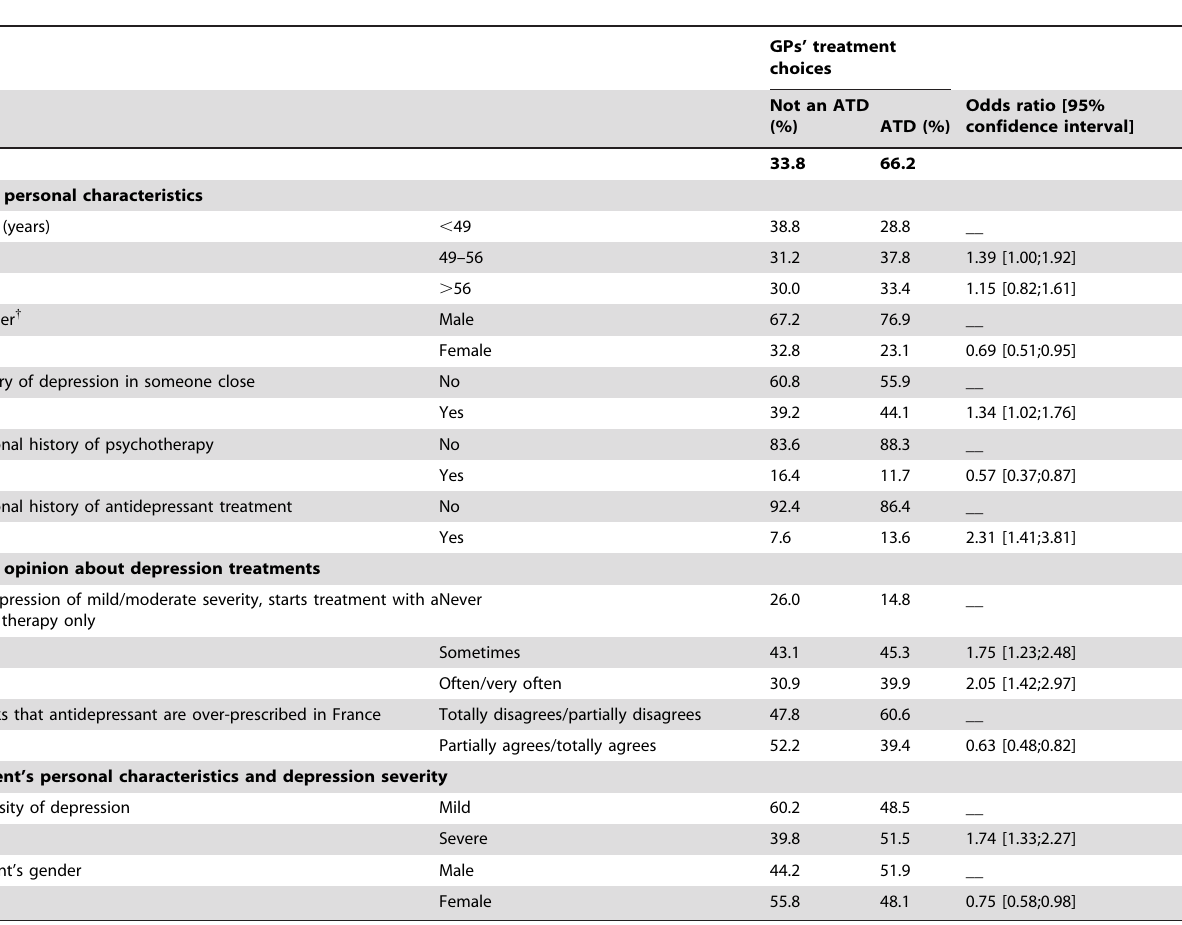
Table 3. Factors associated with the prescription of antidepressant (ATD) treatment versus no antidepressant (Case-vignette, French nationwide panel of general practitioners, weighted multivariate logistic model,